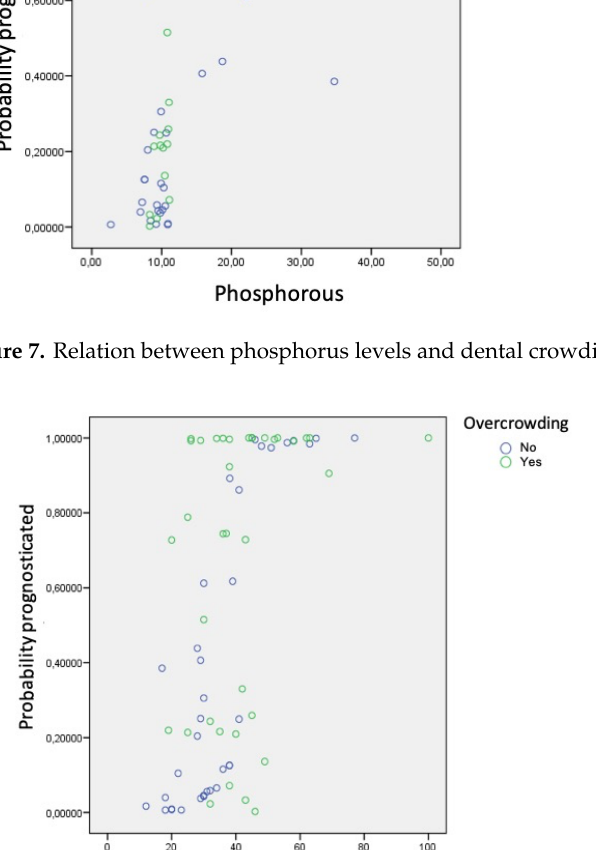
Figure 8. Relationship between levels of urea and dental crowding.